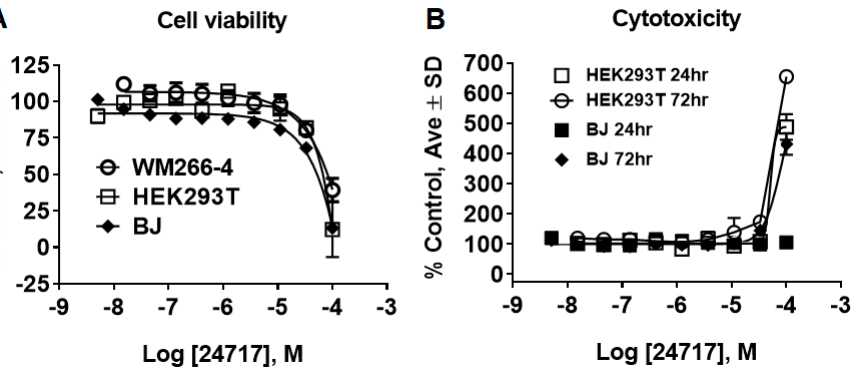
Figure 6. Characterization of SR24717 for effects on cell viability and cytotoxicity. ( A ) Effect of SR24717 on viability of WM266-4 (skin melanoma), HEK293 (kidney), and BJ (skin fibroblasts) cells. CellTiter Glo™ assay (Promega) was used after 72 h treatment. ( B ) Effect of SR24717 on viability of HEK293 (kidney) and BJ (skin fibroblasts) cells. The CellTox Green™ assay (Promega) was used. All experiments performed as 10-point 3-fold concentration-response curves in